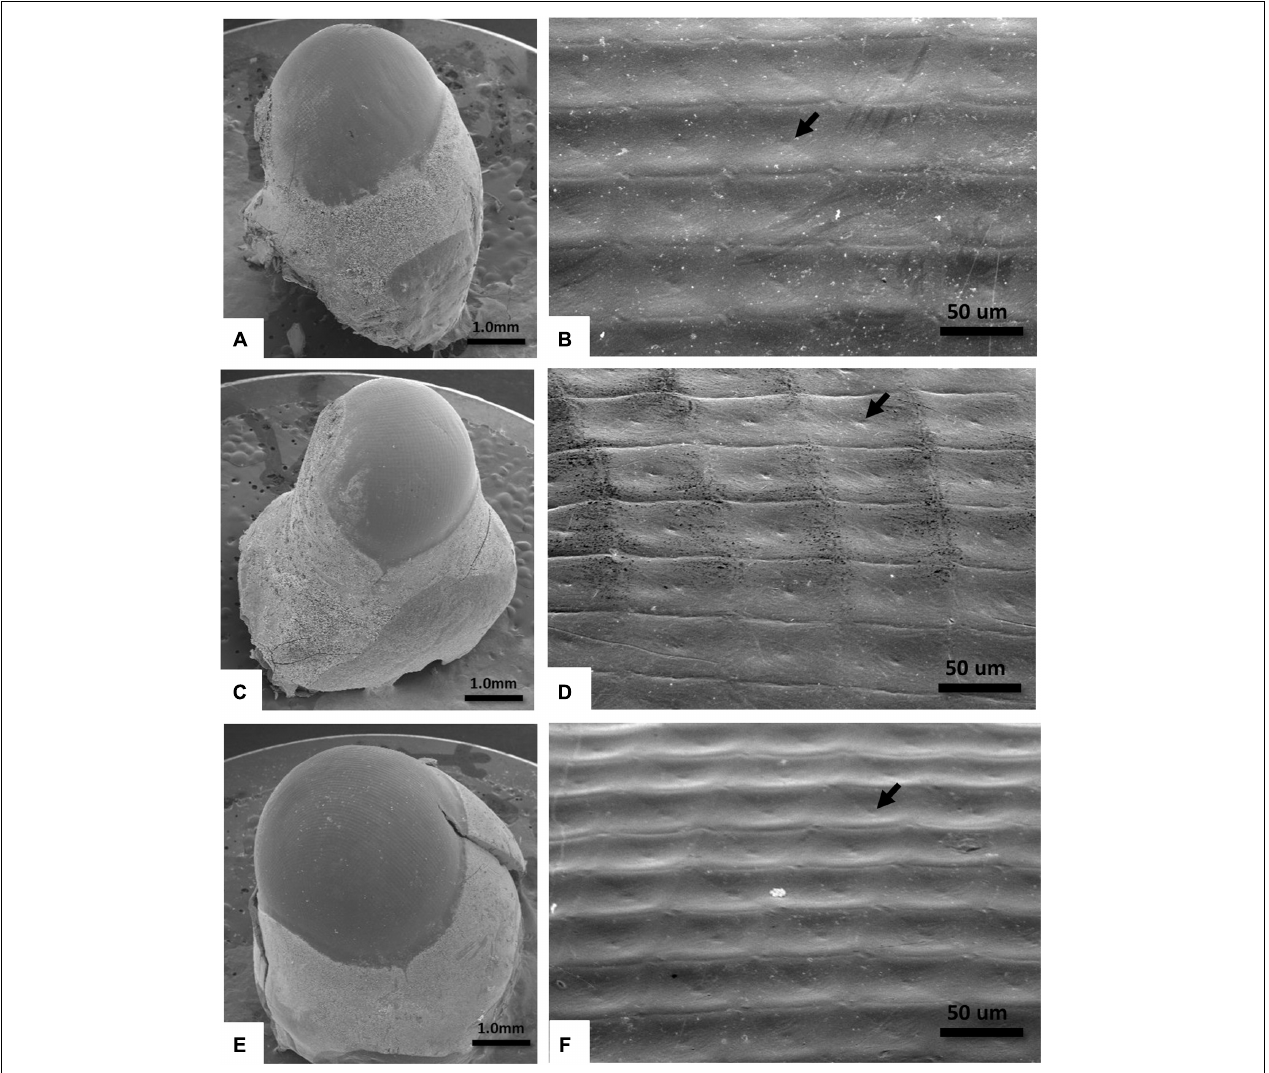
FIGURE 3 | SEM images of the right eye of slipper lobsters. (A,B) S. squammosus 15 × and 400 × , (C,D) I. novemdentatus 15 × and 400 × , and (E,F) P. japonicas 15 × and 400 × . The arrow points to the concavity on the facet.